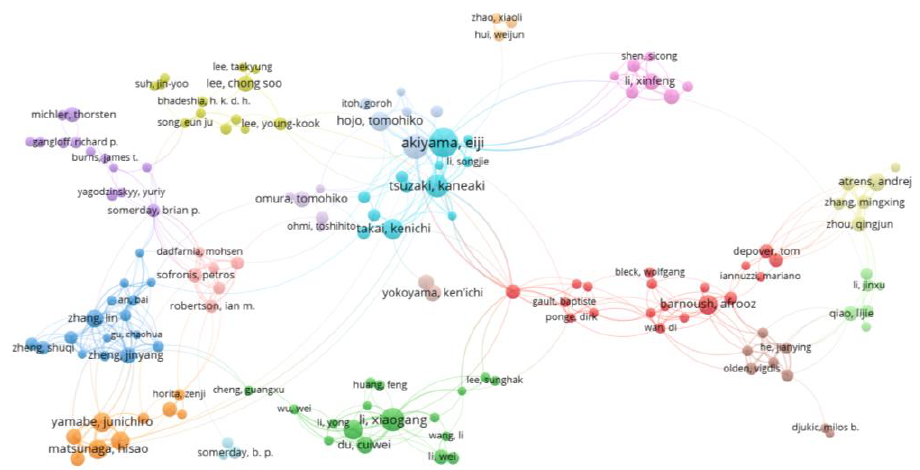
Figure 5. Co-authorship network for research on hydrogen embrittlement.